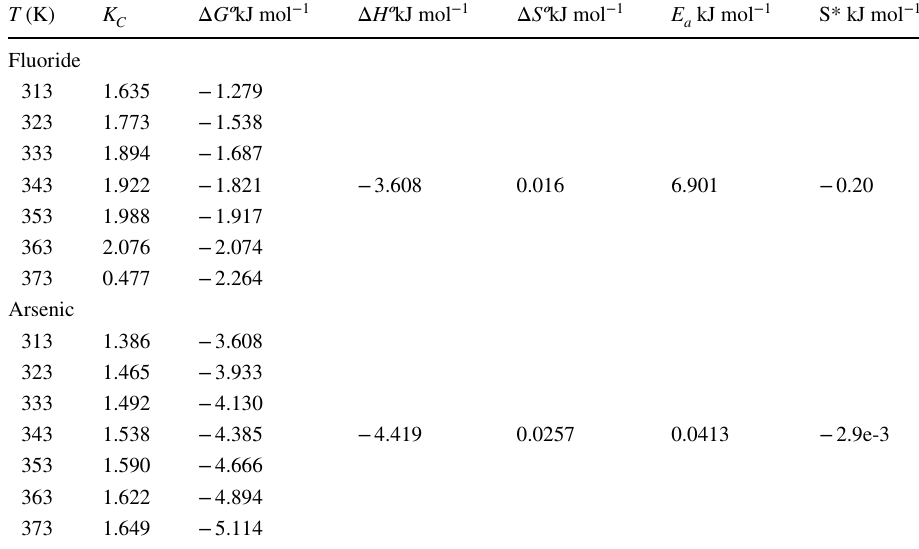
thermodynamic parameters’ values for adsorption of F − and As 3+ onto Fe-KWC nano-